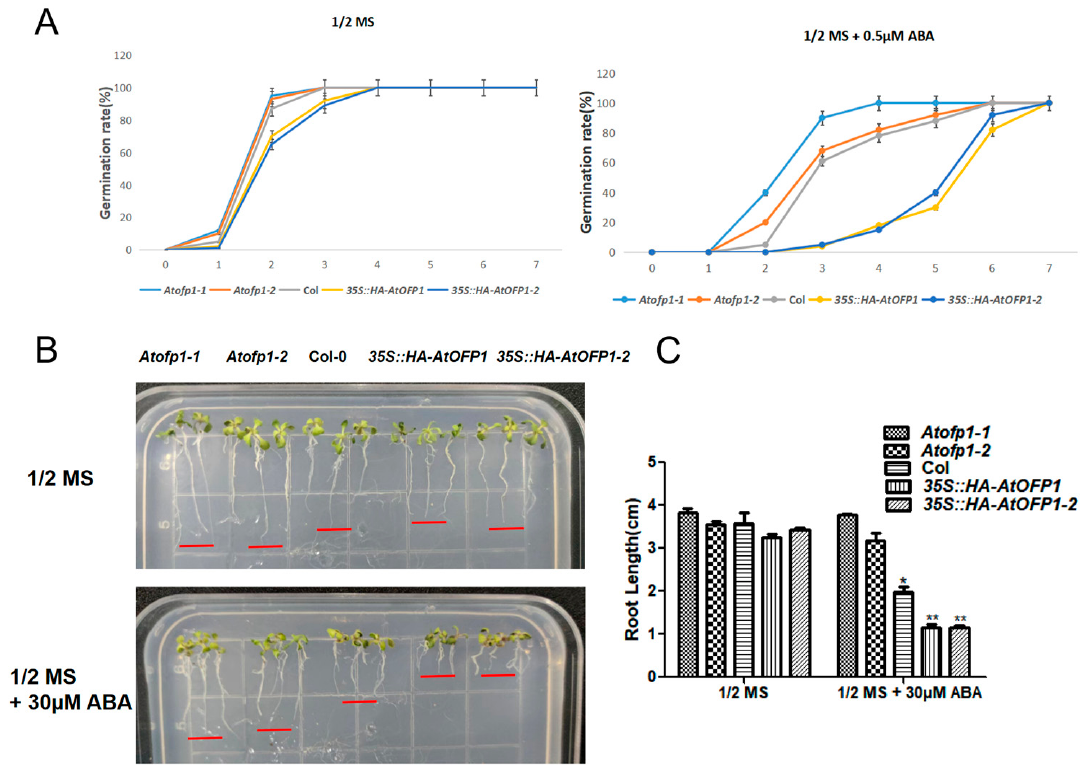
Figure 3. The germination rate and root elongation of Col-0, Atofp1-1 , Atofp1-2 , 35S::HA-AtOFP1 and 35S::HA-AtOFP1-2 under ABA treatment. ( A ) Seed germination of Col-0, Atofp1-1 , Atofp1-2 , 35S::HA- AtOFP1 , and 35S::HA-AtOFP1-2 after 7 days grown on medium 1/2 MS (top panel) and 1/2 MS containing 0.5 µM ABA (bottom panel). At least 50 seeds per genotype were scored in each replicate. ( B ) Root elongation of Col-0, Atofp1-1 , Atofp1-2 , 35S::HA-AtOFP1 , and 35S::HA-AtOFP1-2 were recorded after 7 days’ vertical cultiva- tion on 1/2 MS without ABA (top panel) and on concentrations of 30µM ABA (bottom panel). Data shown are mean ± SD of three replicates. ( C ) Statistical analysis of root length in (B). Data shown are mean ± SD of three replicates. Asterisk (*) indicates statistically different from Col wild-type ( p < 0.05), while ** represents signifi- cantly statistical difference ( p < 0.01).